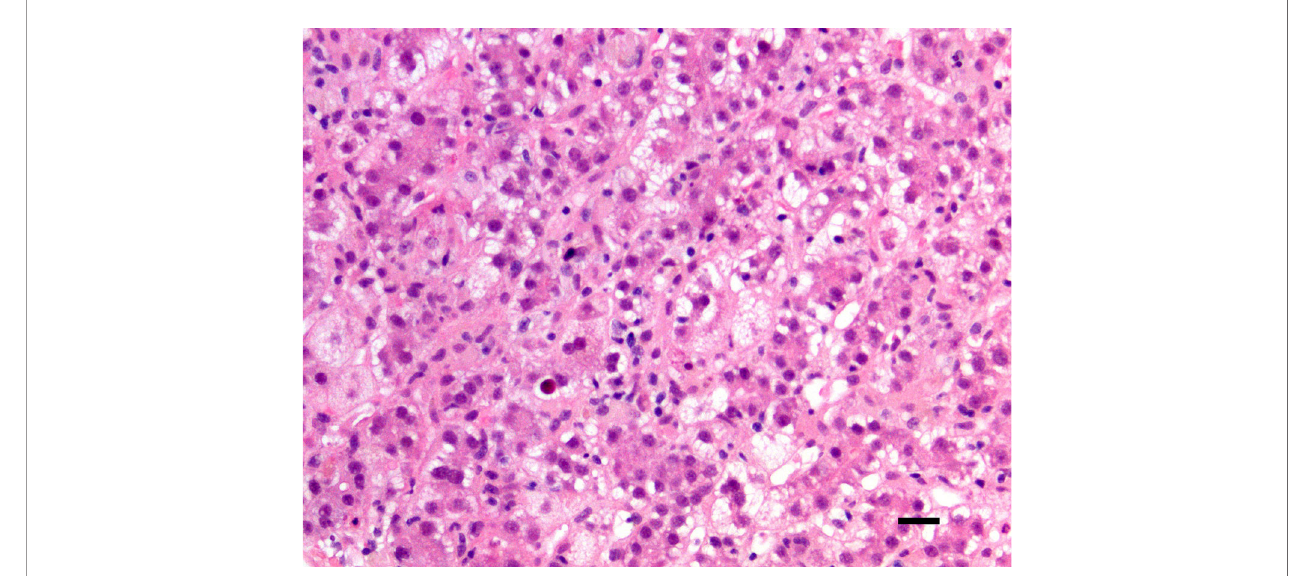
FIGURE 3 | Central lobulus of the liver with hepatocyte ballooning, steatosis, and cell dropout (hematoxylin-eosin staining, ×200 original magni fi cation, bar: 20 micrometers). The patient was a 15-year-old female child with hepatotoxicity due to administered green tea extracts.